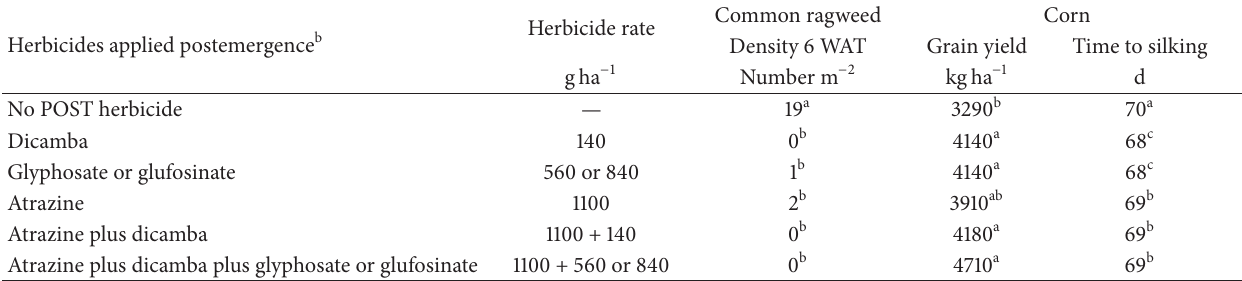
Table 1: Influence of herbicide program on common ragweed density 6 weeks after treatment (WAT), corn grain yield, and days from planting to silking during 2011 a .